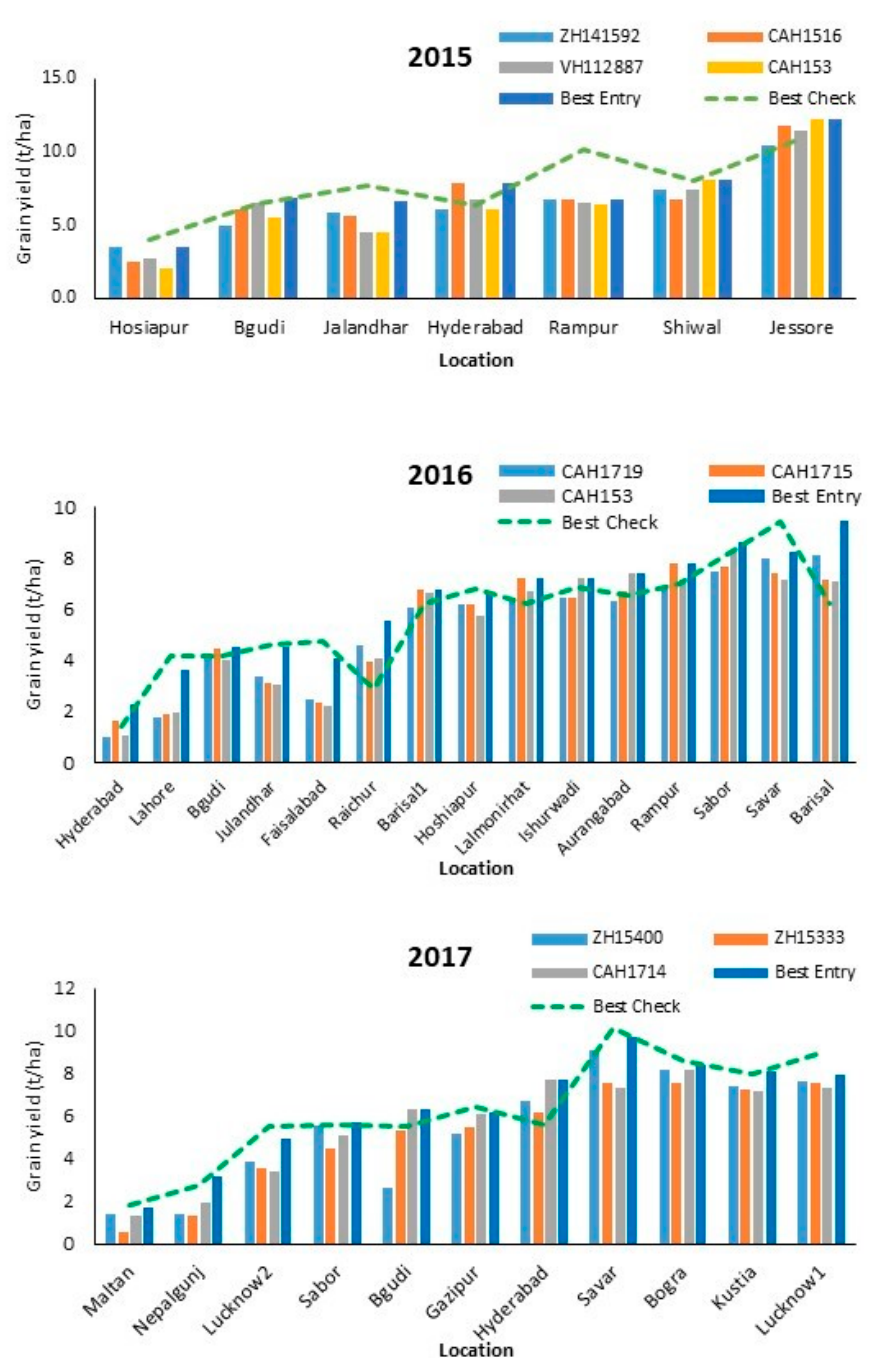
Figure 3. Performance of top ranking entries in comparison to the best check and the best entry.